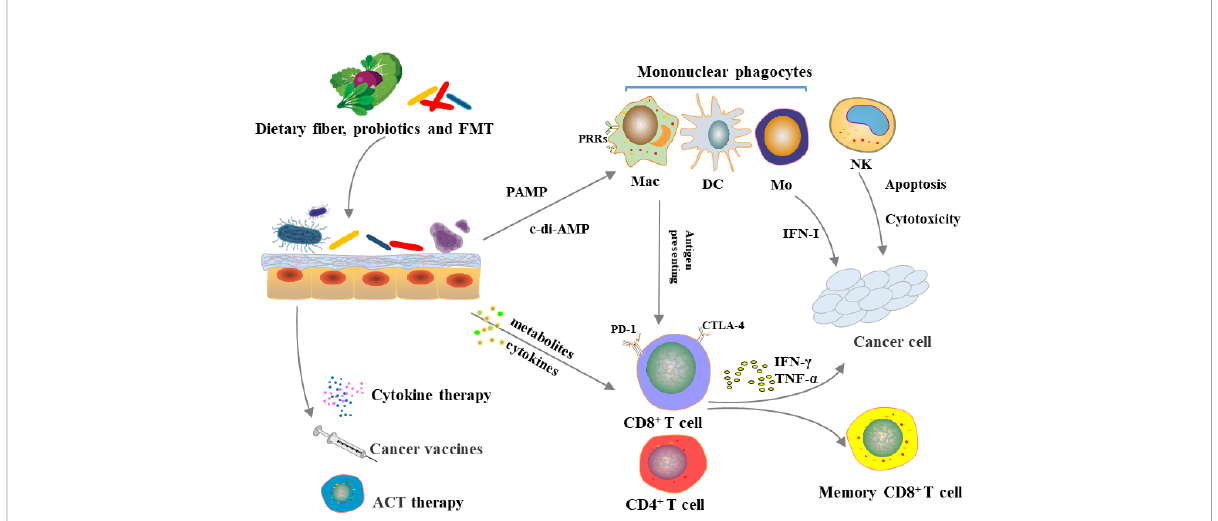
FIGURE 2 Microbiome, immune system and cancer immunotherapy.Diet, probiotic use and FMT can alter gut microbiota. The microbiota can directly in fl uence innate and adaptive immunity or indirectly in fl uence immune system through metabolism, which in turn affects the ef fi cacy of immunosuppressive checkpoint inhibitors, cytokine therapy, tumor vaccines, and adoptive cell transfer